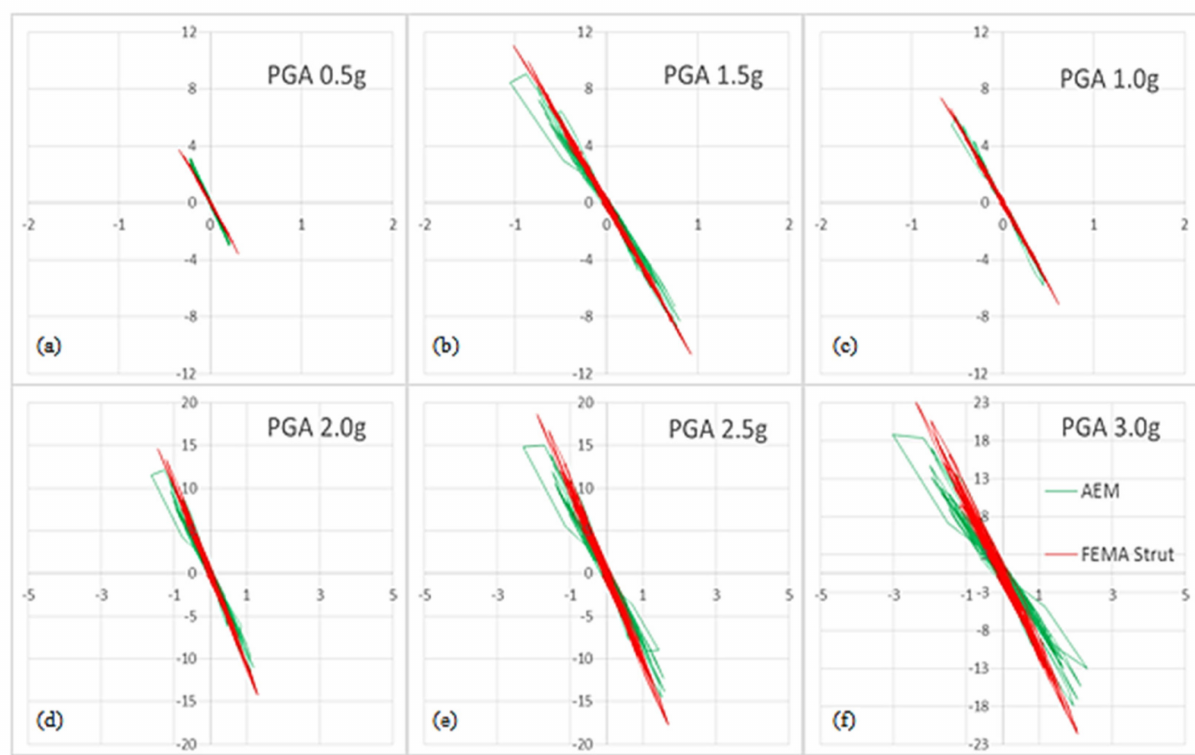
Figure 19. Comparison of base shear and top lateral displacements for FEMA Strut and AEM models for H-building structure (RC and IFM) at PGA: ( a ) 0.5 g; ( b ) 1.5 g; ( c ) 1.0 g; ( d ) 2.0 g; ( e ) 2.5 g; ( f ) 3.0 g.